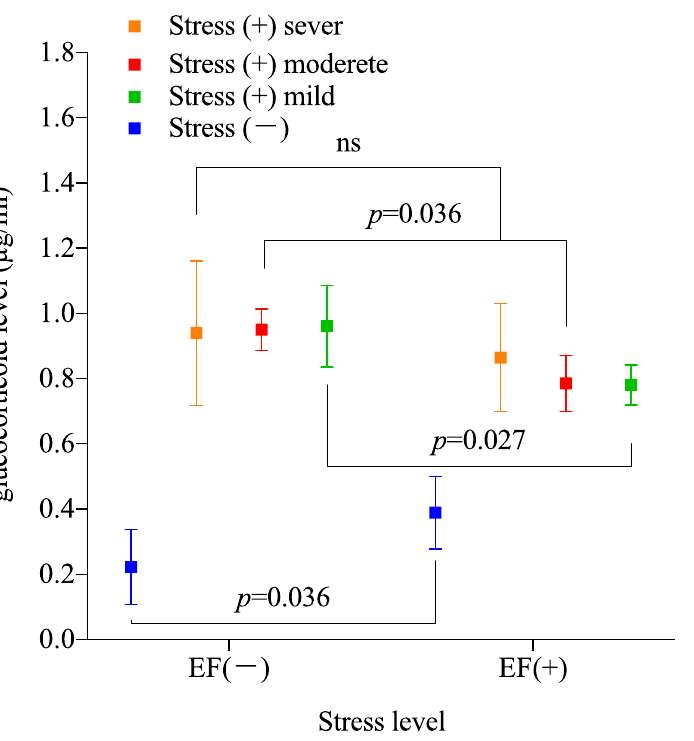
Figure 5. EF-induced stress suppression compared for different immobilization degrees. Two-way ANOVA was performed with presence or absence of EF and stress as main effect for six groups. For two-way ANOVA and main effect stress, F(2, 42) = 273, p = 0.7281. For EF, F(1, 42) = 13.17, p = 0.0008. For interaction, F(2, 42) = 0.7272, p = 0.4892. For Sidak’s multiple comparisons, the p -value between stress(−)/EF(−) and stress(−)/EF(+) is 0.0354 under moderate stress, 0.0295 under mild stress, and 0.2691 under severe stress. (ns, no significant difference).